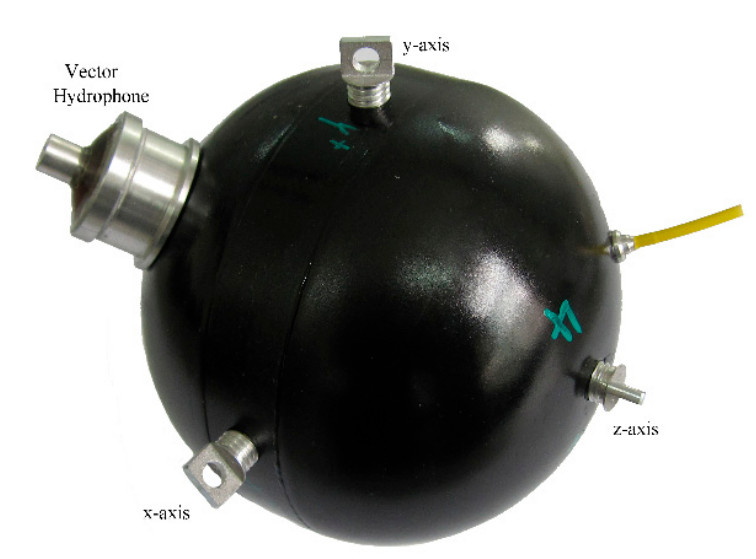
Sensors 2020 , 20 , x